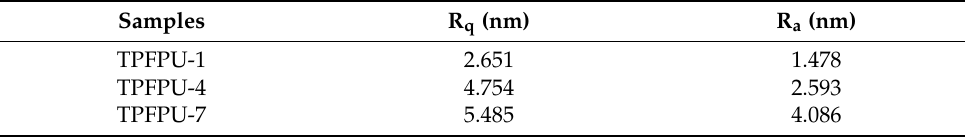
Table 3. Roughness parameters of the TPFPU latex